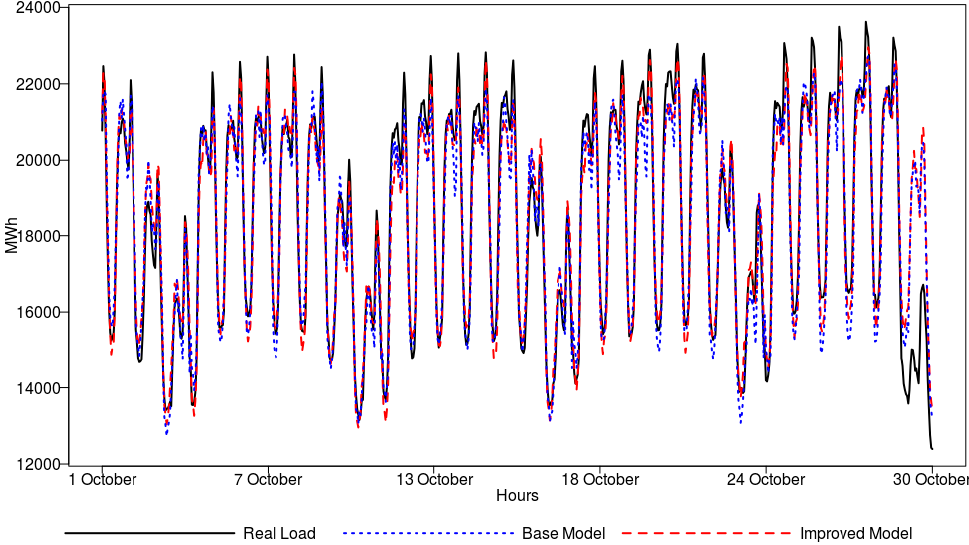
Figure 7. Forecasting results of the base model and the improved ANN model (enhanced by peak classification data) covering October 2015 data.